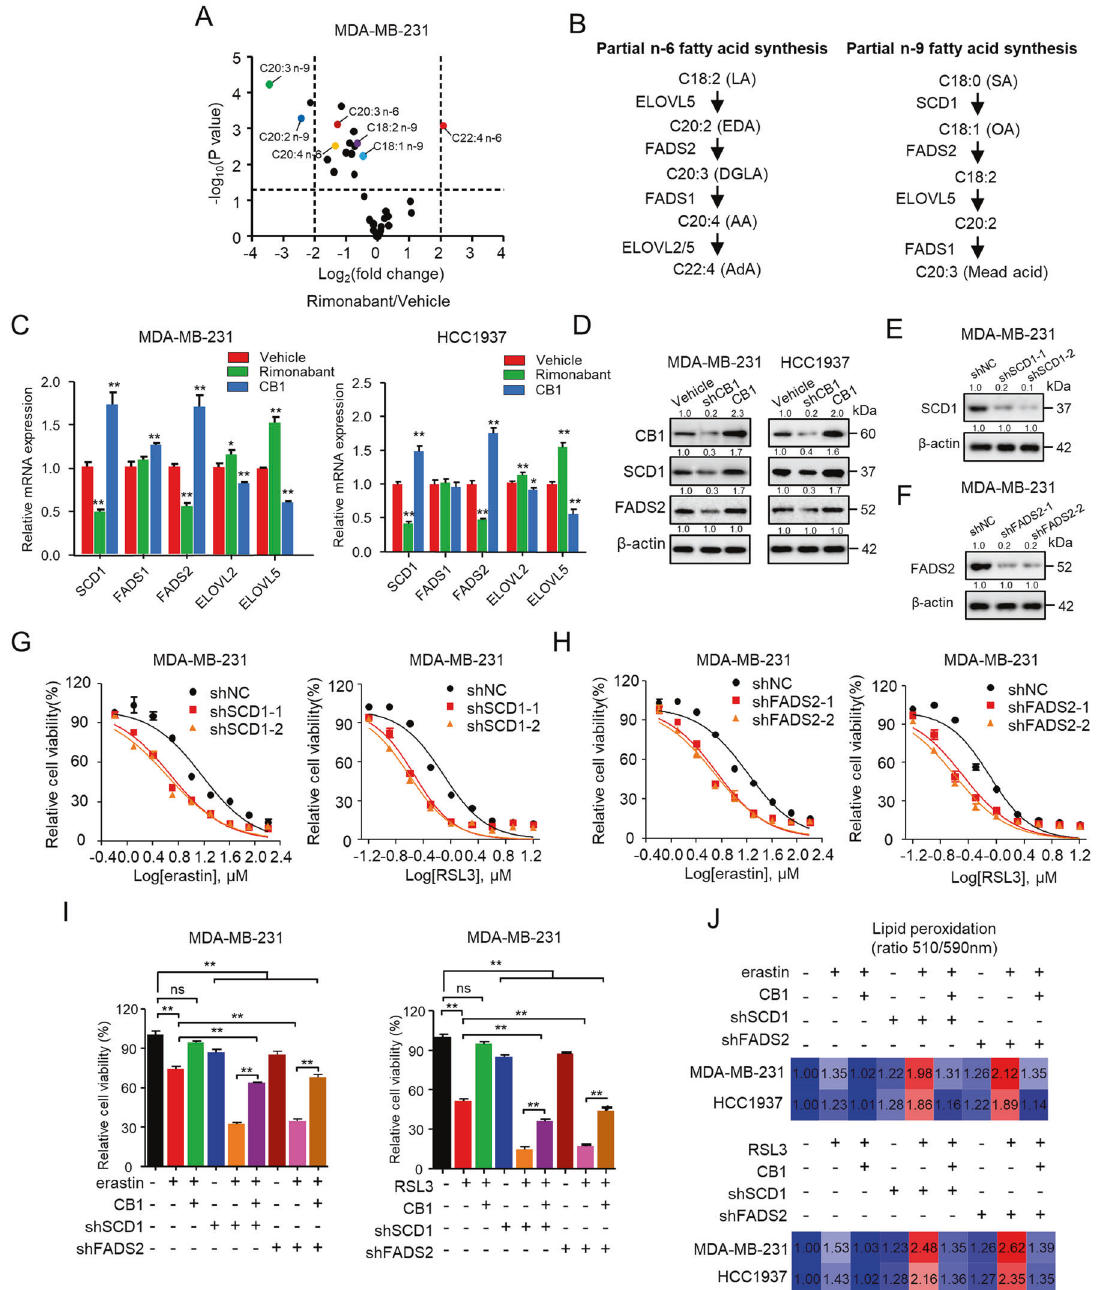
Fig. 4 CB1 regulated sensitivity of TNBC cells to ferroptosis by regulating SCD1- and FADS2-dependent fatty acid metabolism. A Volcano plot showing fold changes and P -values for fatty acid species in rimonabant treated MDA-MB-231 cells compared with vehicle treatment. B Scheme showing the n-6 fatty acid and n-9 fatty acid partial synthesis pathway. n-6 fatty acid pathway: OA oleic acid, LA linoleic acid, EDA eicosadienoic acid, DGLA dihomo- γ -linolenic acid, AA arachidonic acid, AdA adrenic acid. n-9 FA pathway: SA stearic acid, OA, oleic acid; MA, mead acid. C qPCR analysis of the indicated gene expression associated with fatty acid metabolism in MDA-MB-231 and HCC1937 cells treated with rimonabant or CB1 overexpression. * p < 0.05, ** p < 0.01 ( t -test). D WB analysis was conducted to detect CB1, SCD1 and FADS2 in MDA- MB-231 and HCC1937 cells that were stably transfected with control vector, shCB1 or CB1. E – H Effect of SCD1 and FADS2 knockdown on MDA- MB-231 cells in response to erastin and RSL3 treatment, respectively, using two distinct target gene shRNA expression vectors. WB analysis was conducted to detect SCD1 ( E ) and FADS2 ( F ) in MDA-MB-231 cells that were stably transfected with negative control shRNA (shNC), shSCD1 or shFADS2. Dose-response curves of MDA-MB-231 cell stably transfected with negative control shRNA (shNC), shSCD1 ( G ) or shFADS2 ( H ) treated with erastin (left) or RSL3 (right) at the indicated doses. The cell viability was assessed by CCK-8 assay after treatment for 72 h with the indicated doses of the drugs. I The cell viability of MDA-MB-231 cells stably transfected with empty vector, CB1, shFADS2 was treated with erastin (5 μ M) or RSL3 (0.5 μ M). Cell viability was assessed by CCK-8 assay after treatment for 72 h with the indicated doses of the drugs. ns (no signi fi cance), ** p < 0.01 (one-way ANOVA). J Effect of CB1 overexpression, SCD1 and FADS2 knockdown on lipid peroxidation response to erastin (up) and RSL3(down) treatment, respectively, in MDA-MB-231 and HCC1937 cells. Data shown are mean ± SD of triplicate measurements that were repeated three times with similar results.